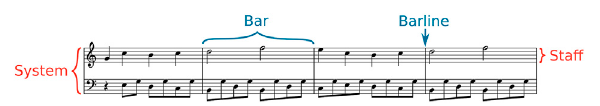
FIGURE 1 | Example of a single system with two staves and 4 bars (or measures). Note that this is also an illustration of ambiguities in sheet images. Bars 2 and 4 share the same musical content and without a large enough temporalcontext,ascorefollowerwillnotbeabletodistinguishbetween them. However, if it is able to remember that it has already encountered the fi rstsequenceofnotesinbar2thenitcancorrectlypredictthecurrentposition to be in the last